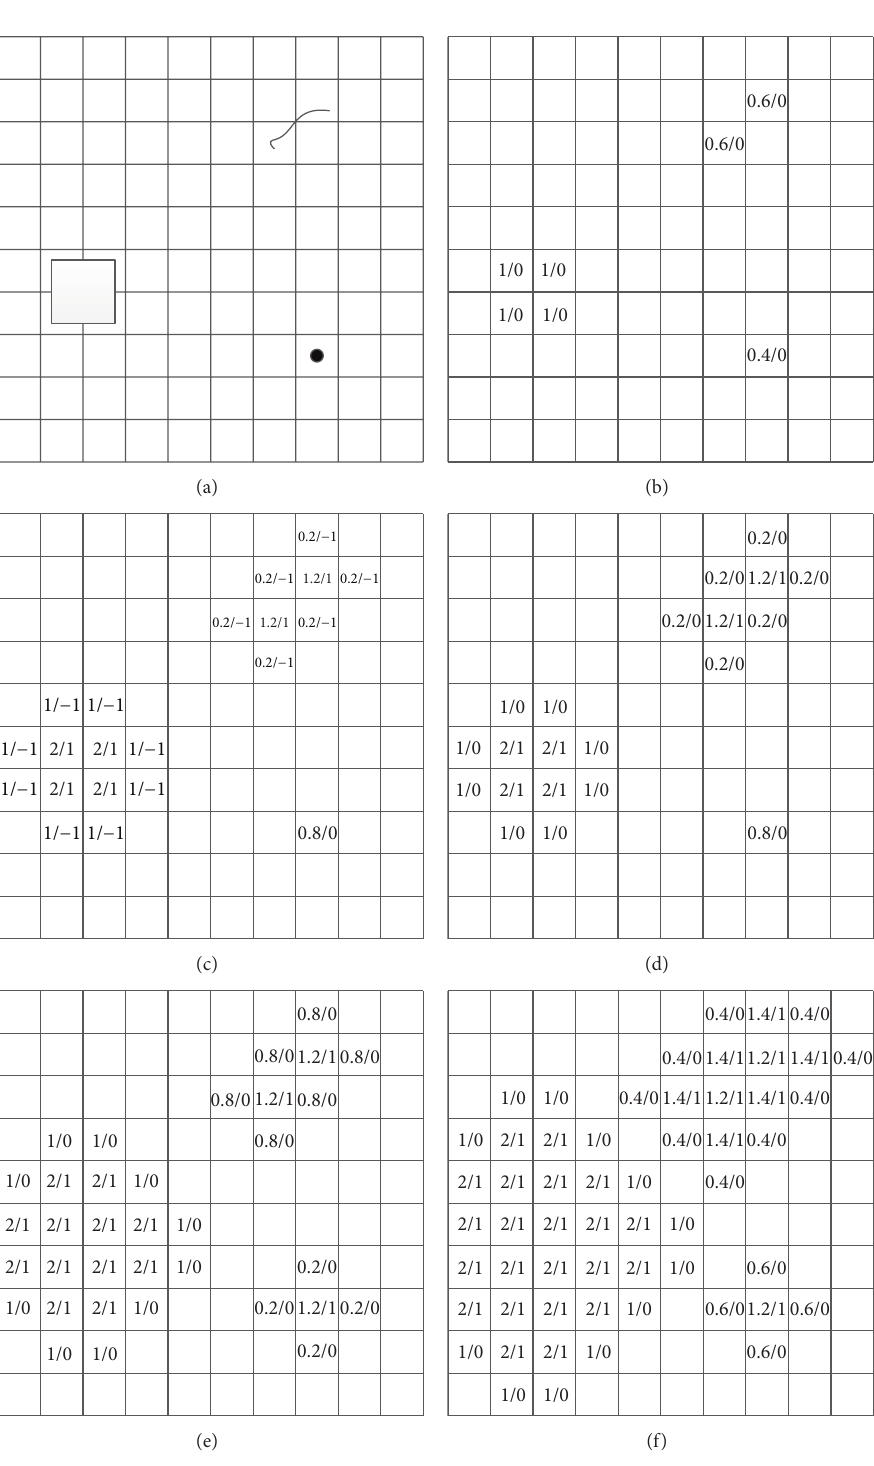
(𝑔 )/𝑠(𝑔 ) ” if it intersects with a generator, in which 𝑡 𝑐 𝑗 𝑗